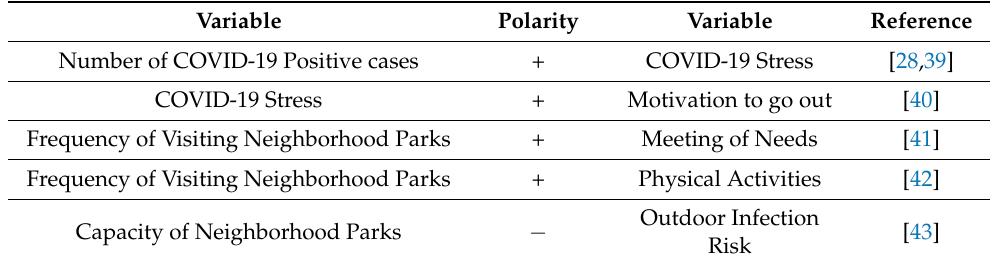
Table 3. Reference of major